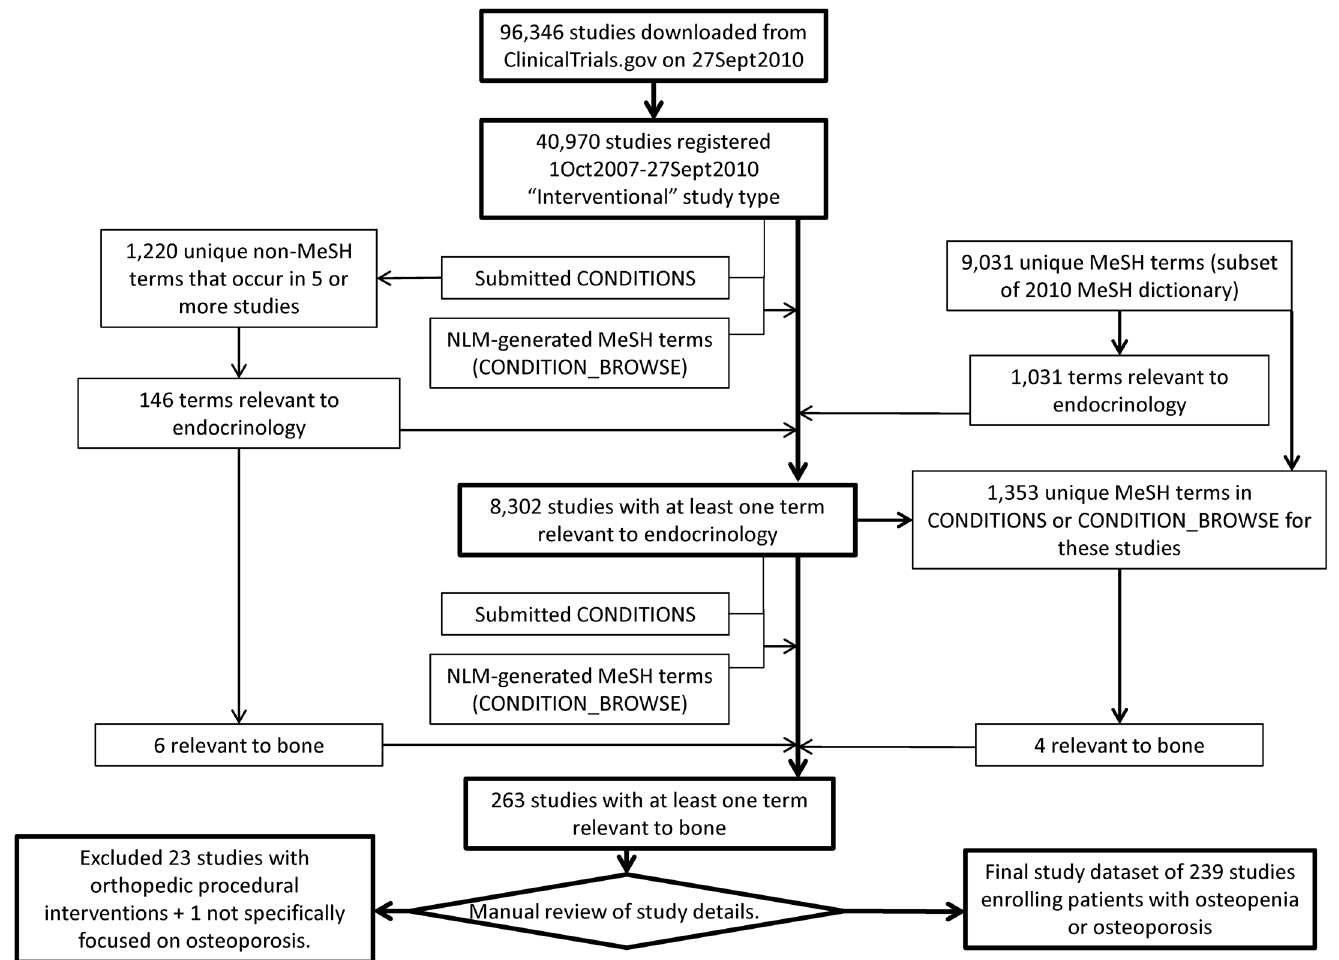
Fig 1. Flow Diagram Illustrating the Creation of the Osteoporosis Trials